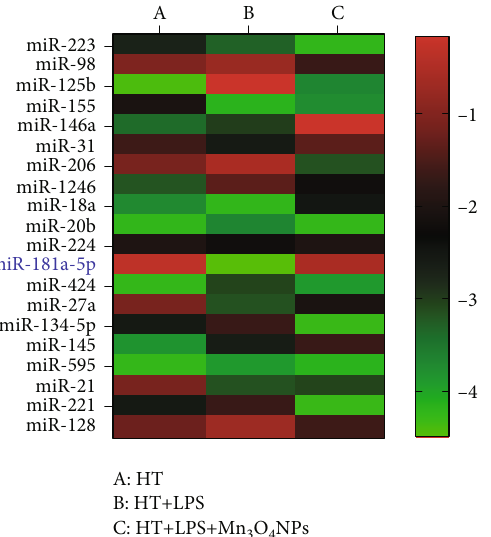
Figure 3: Mn O nanoparticles e ff ect on the expression of in fl ammatory-related miRNA in human tendon cells induced by LPS. 3 4